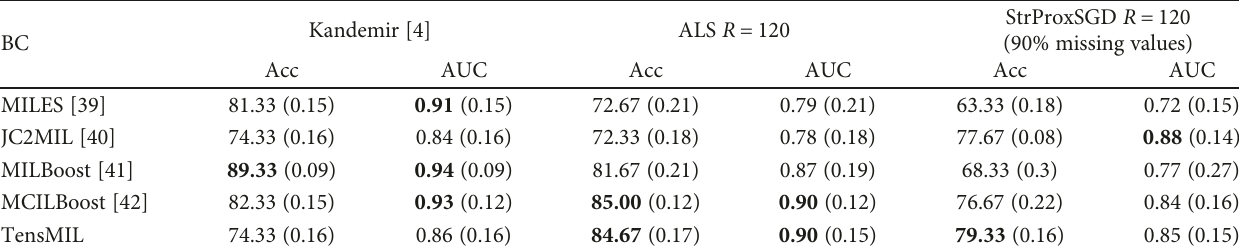
Table 2: Tenfold cross-validation mean test accuracy and mean AUC for the BC dataset.